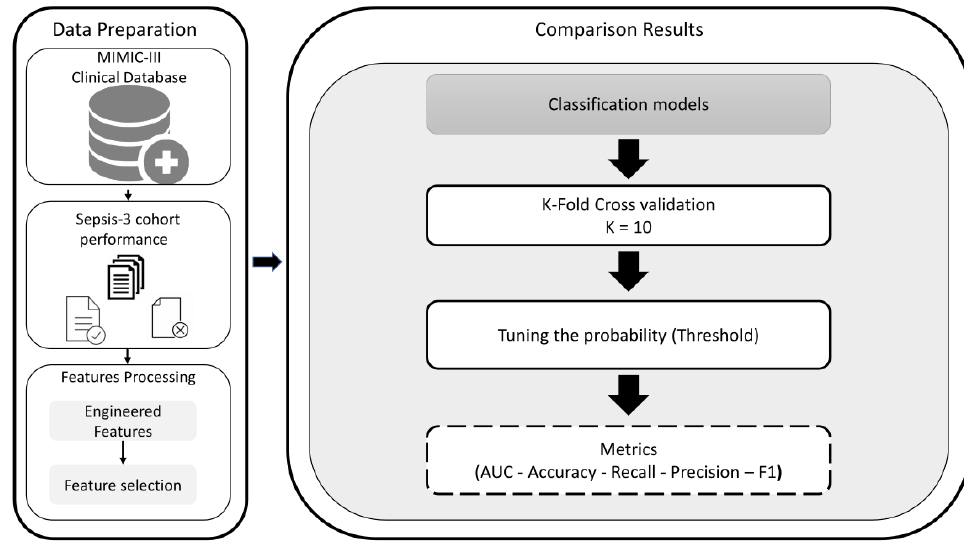
Figure 1. Architecture of the proposed